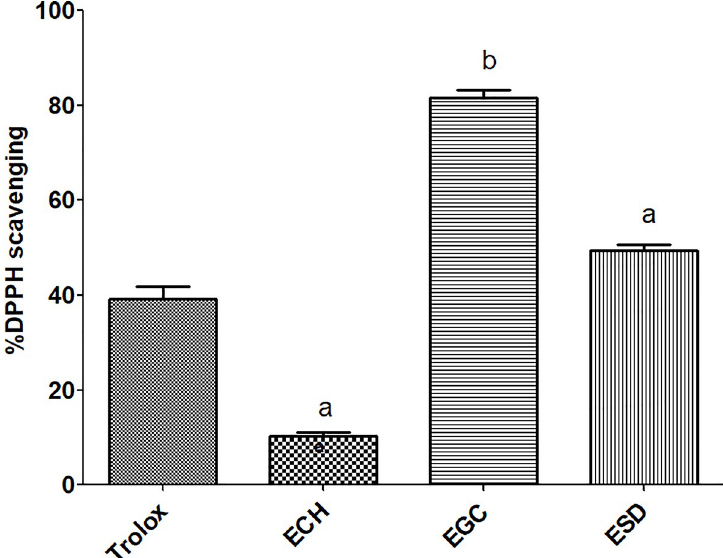
Fig 2. DPPH • radical scavenging activity of selected herb extracts after treatment with 100 μ g/mL of each extract and the standard compound (a = p-value < 0.05, b = p-value < 0.001).